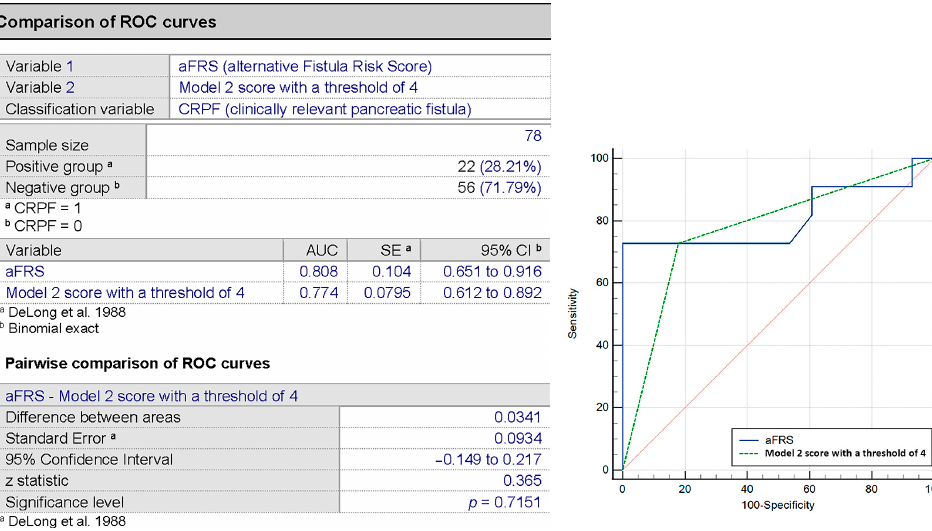
Figure 7. Comparison of the alternative fistula score and our proposed model for the prediction of CRPF. of